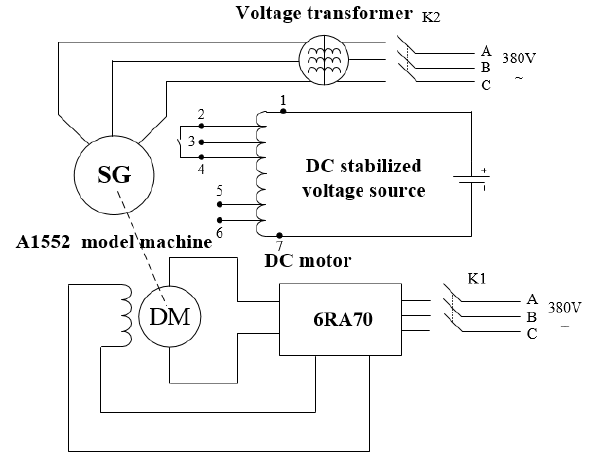
Figure 5. Experimental wiring diagram.